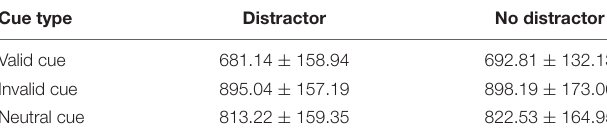
TABLE 2 | Mean reaction time and standard deviation ( ms ) in each task